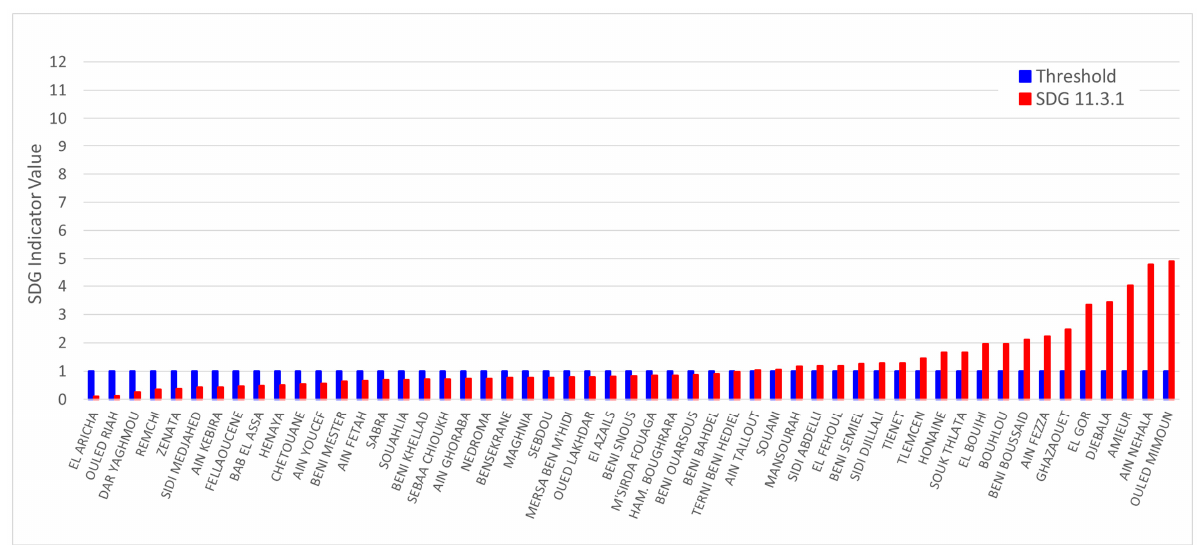
Figure 6. SDG 11.3.1 indicator values for the communes in the Tlemcen wilaya. The constant blue bars represent the value over which the commune develops away from sustainability.